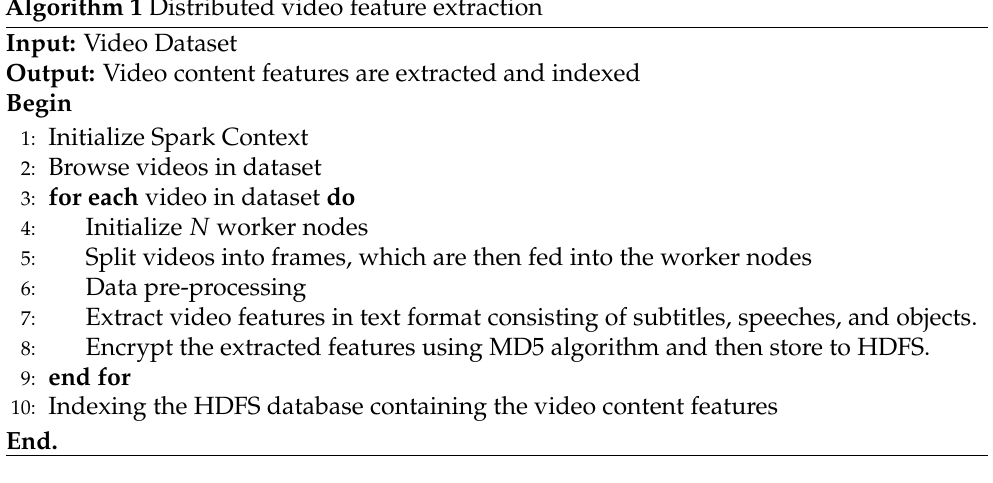
Figure 6. Distributed and parallel processing model with Spark for video feature extraction. Algorithm 1 Distributed video feature